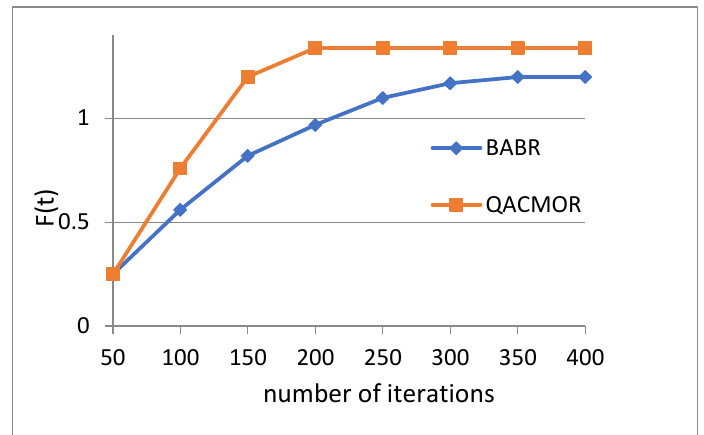
Figure 6. Value of optimal route vs. number of nodes.